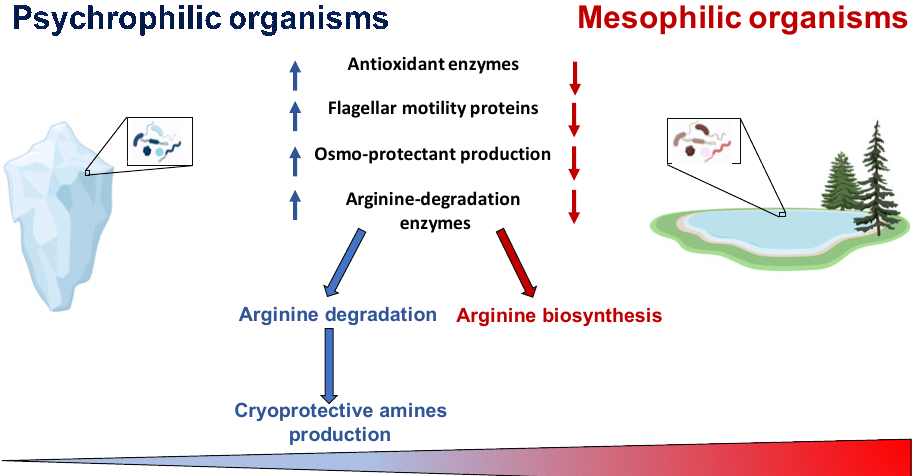
Figure 2. Metabolic adaptation. Image created with a template from BioRender.com.